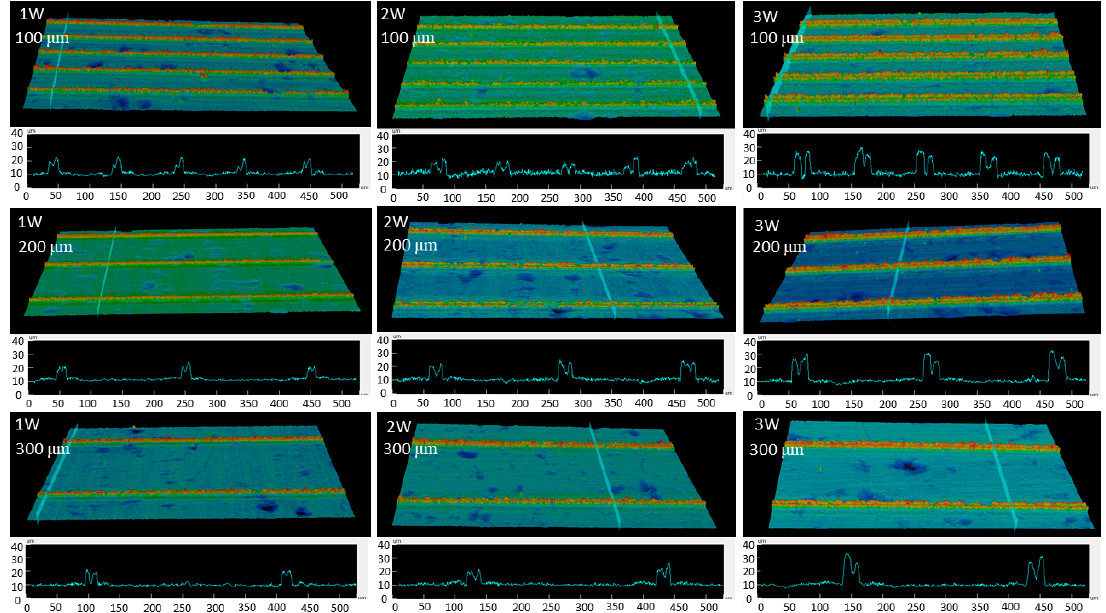
Figure 4. Confocal microscopy images of the line-patterned samples with a step size of 100, 200, and 300 µm at a laser power of 1, 2, and 3 W.